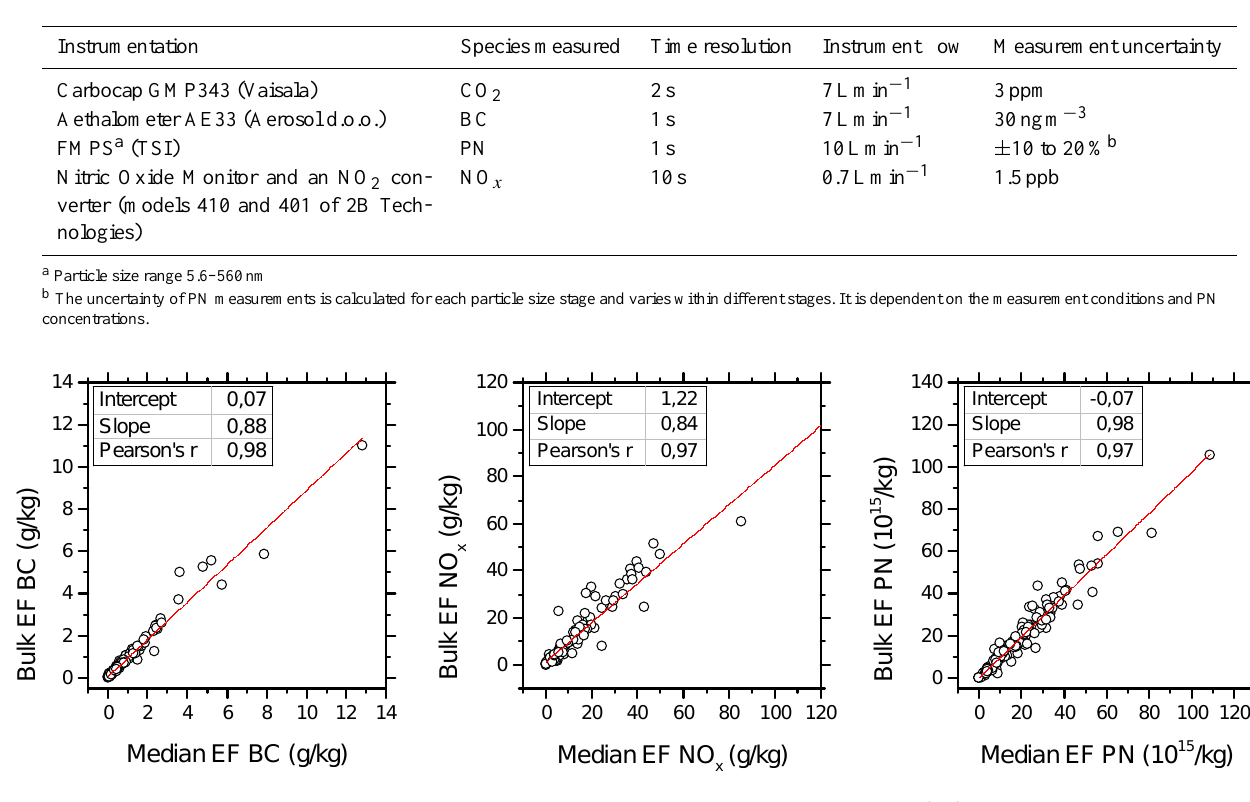
Figure 1. Comparison of two integration approaches to calculate individual vehicle’s emission factor (EF). With the bulk integration, the EF is calculated by integrating the plume from the beginning to the end of the chase; the median EF is calculated with the running integration approach with 10s integration windows, from the EF distribution the median value is then